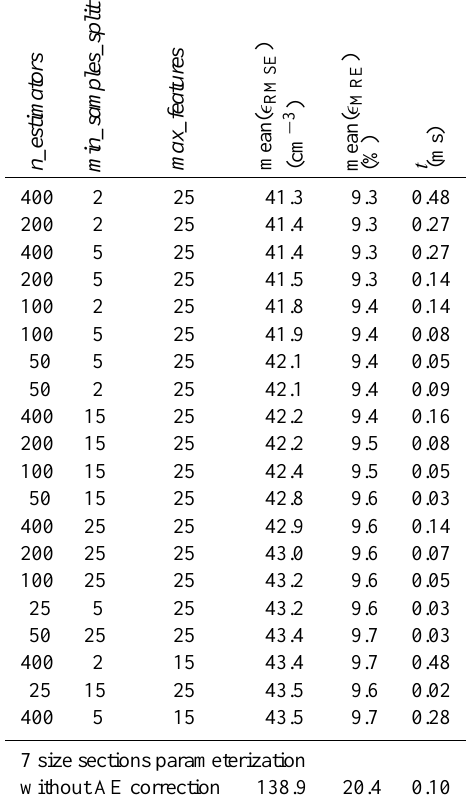
Table 5. Training parameters and results of the AE correc- tion in the case of 7 size sections parameterization: number of trees in the RF model n_estimators , the RF training parameters min_samples_split , and max_features , the mean values of root- mean-squared errors (cid:15) RMSE (RMSE) and mean relative errors (cid:15) MRE (MRE), and the average time used for evaluating the RF model t .